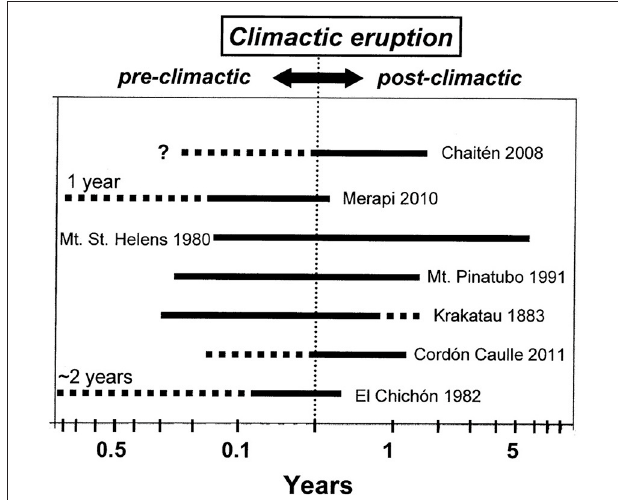
FIGURE 1 | Timescales of activity at fast volcanic systems, including precursory activity, climactic activity, and waning activity. Dashed lines indicate uncertainty in durations. For Chaitén, Pinatubo, and Krakatau, the degree of uncertainty is larger because these volcanoes were not monitored prior to the climactic